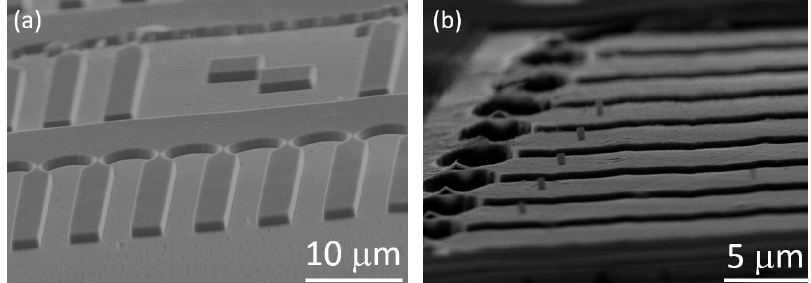
Figure 3. ( a ) Devices at intermediate stage of the process with etched-in platforms. Note that the SEM image shows the bare SCD structures that have been obtained via removing the adhesion layer using the SF 6 pulse followed by anisotropic O 2 RIE and subsequent cleaning. ( b ) HSQ masks for pillars etching written by EBL. The masks are residing on SCD platforms coated by a freshly evaporated silicon layer. Note that the silicon layer is not discernible in the SEM